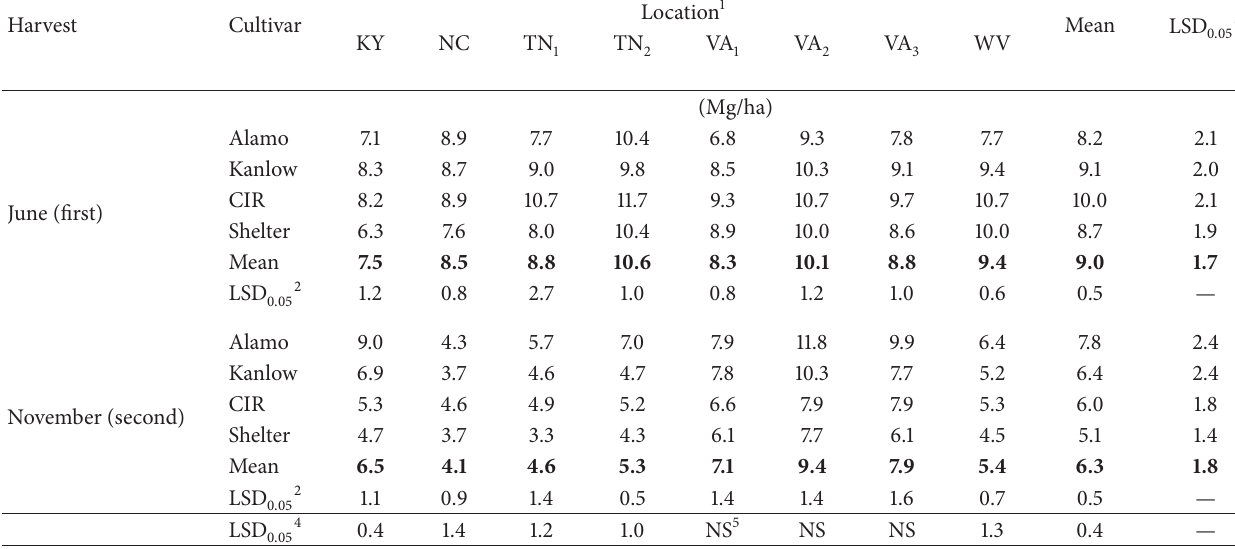
Table 7: Effect of harvest date (first and second harvests) and cultivar on biomass yield of switchgrass grown at eight locations across upper southeast USA under two-cuts (high input and management). Data are averaged across 2 years (CIR: Cave-in-Rock). Harvest Cultivar